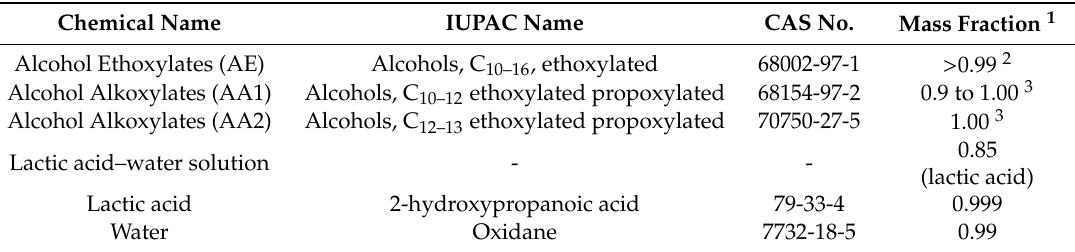
Table 1. Materials used in the phase equilibrium